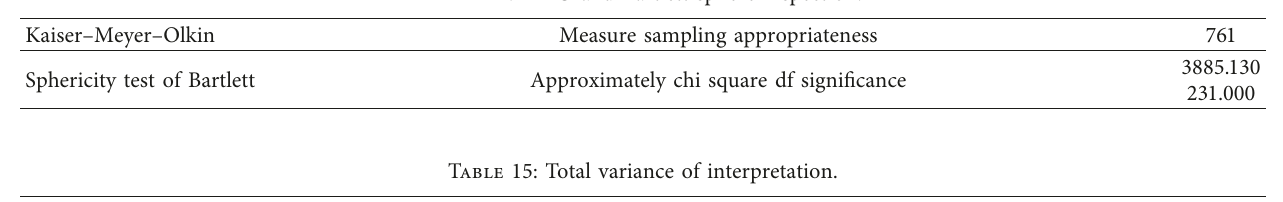
Table 14: KMO and Bartlett sphere inspection.